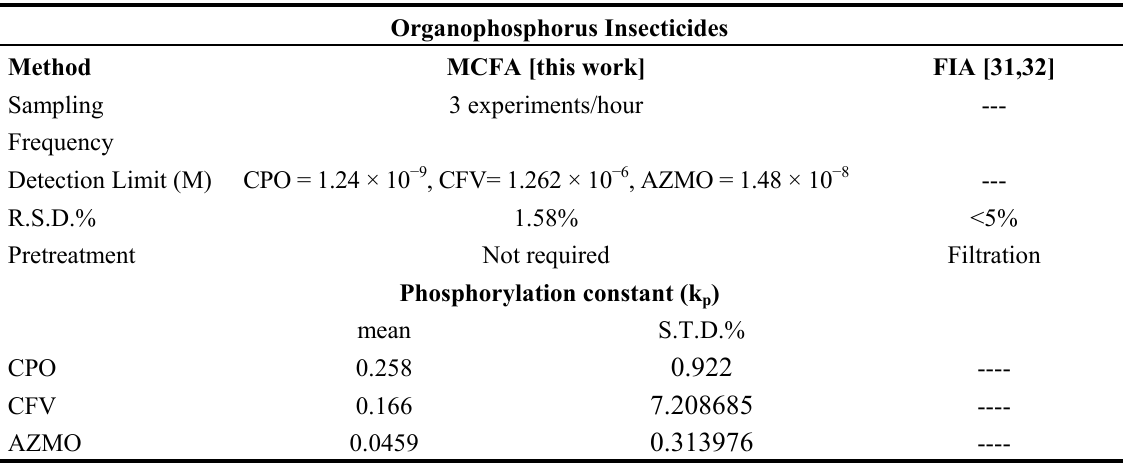
Table 2. Comparison between MCFA system described and previous FIA systems